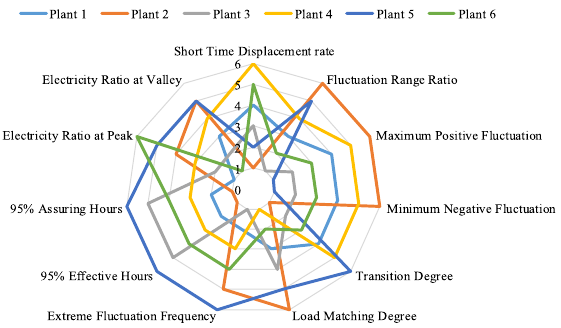
Fig. 5 The distribution pattern of individual